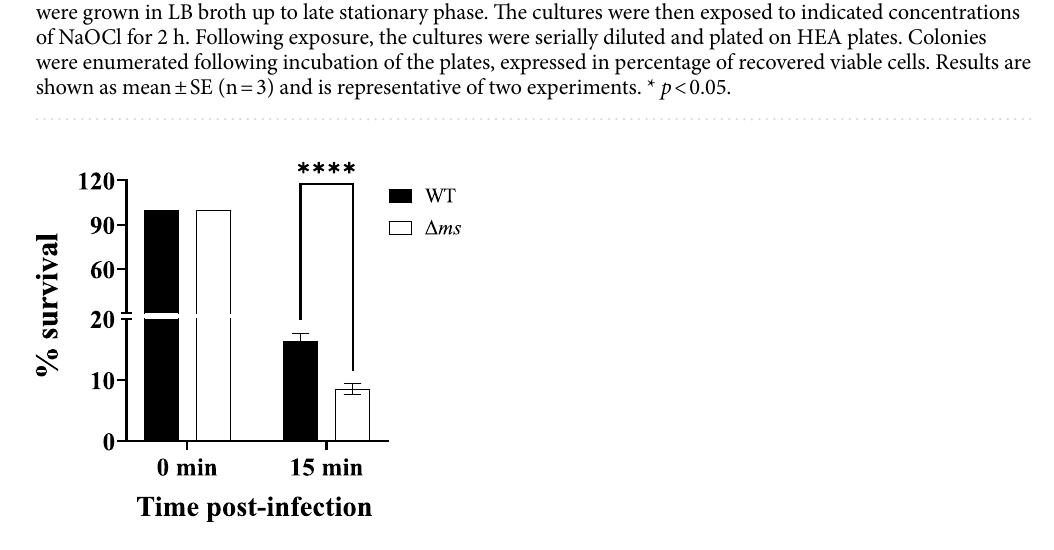
Figure 3. Δ ms strain shows hypersensitivity to neutrophils: the neutrophils were infected with WT and Δ ms strains of S. Typhimurium @ MOI of 10:1 (bacteria:cells). Following 15 min of incubation, the neutrophils were lysed by Triton X-100. The lysates were serially diluted and plated on HE agar plates. Colonies were enumerated following incubation of the plates. Comparison of percentage of recovered WT and Δ ms strains of S. Typhimurium after 0 min and 15 min post-infection is shown. Data are presented as mean ± SE (n = 5). **** p <